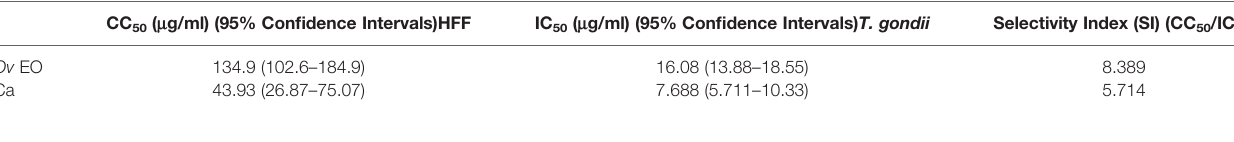
TABLE 1 | Anti- T. gondii activity and cytotoxic effects of Ov EO or Ca. CC 50 ( m g/ml) (95% Con fi dence Intervals)HFF